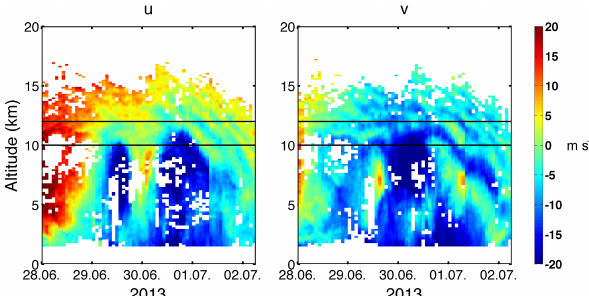
Figure 1. Example of zonal ( u ) and meridional ( v ) wind speed mea- surements of PANSY radar between 28 June and 2 July 2013.